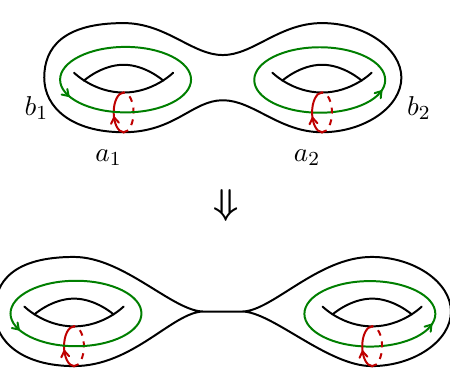
Figure 2. Factorization of a genus 2 Riemann surface. The a cycles are depicted in red, b cycles in green. Under the factorization, the one-form ω Ω = H ω 2 = 0 , so that r = e 2 πi Ω 12 → 1 12 b 1